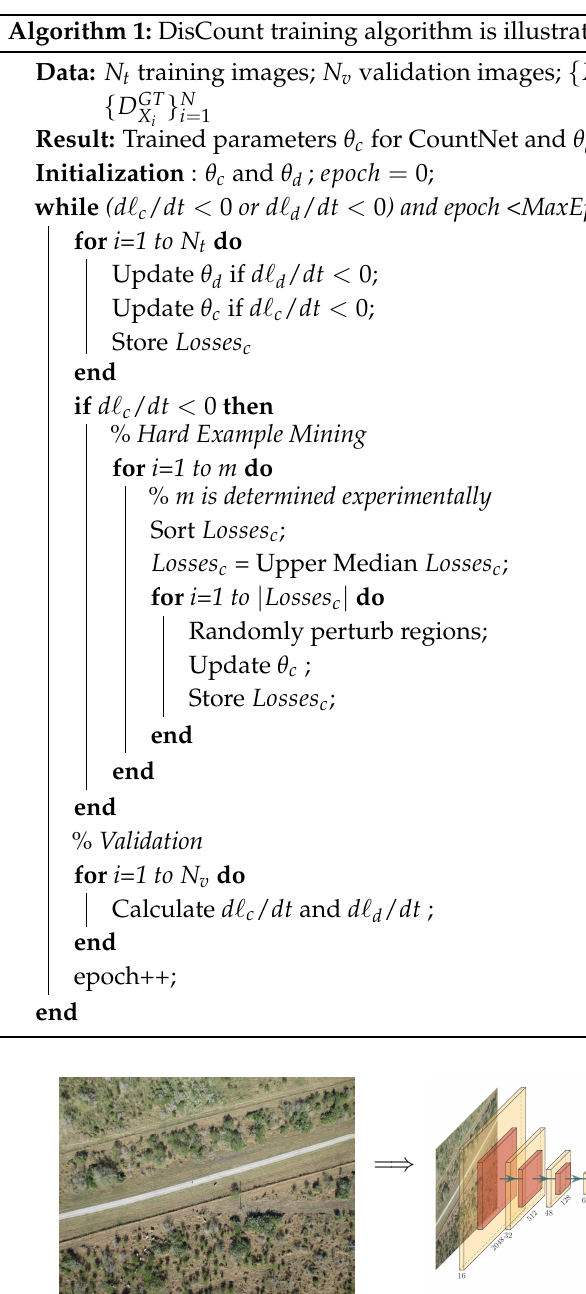
with ground-truth density maps i = 0